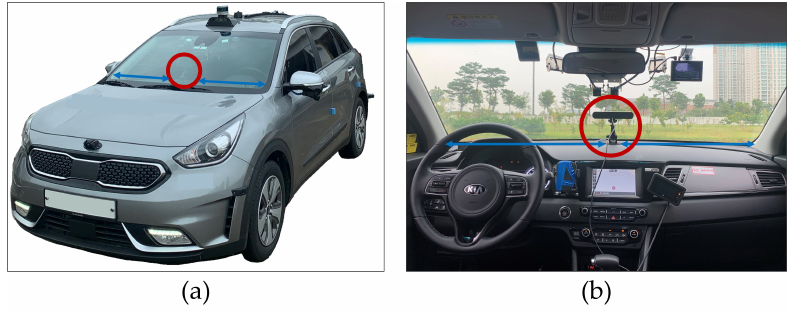
Figure 5. Hardware setup for data acquisition: ( a ) experimental vehicle; ( b ) the camera in the cockpit to capture the frontal view of driving under rainy weather